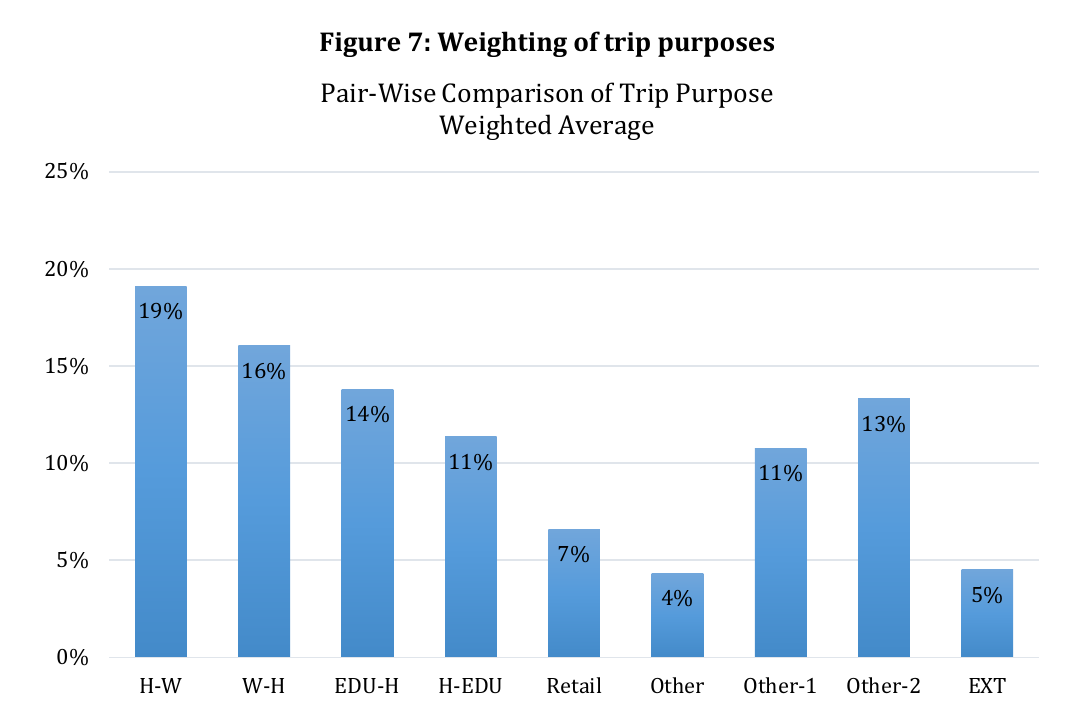
Figure 7: Weighting of trip